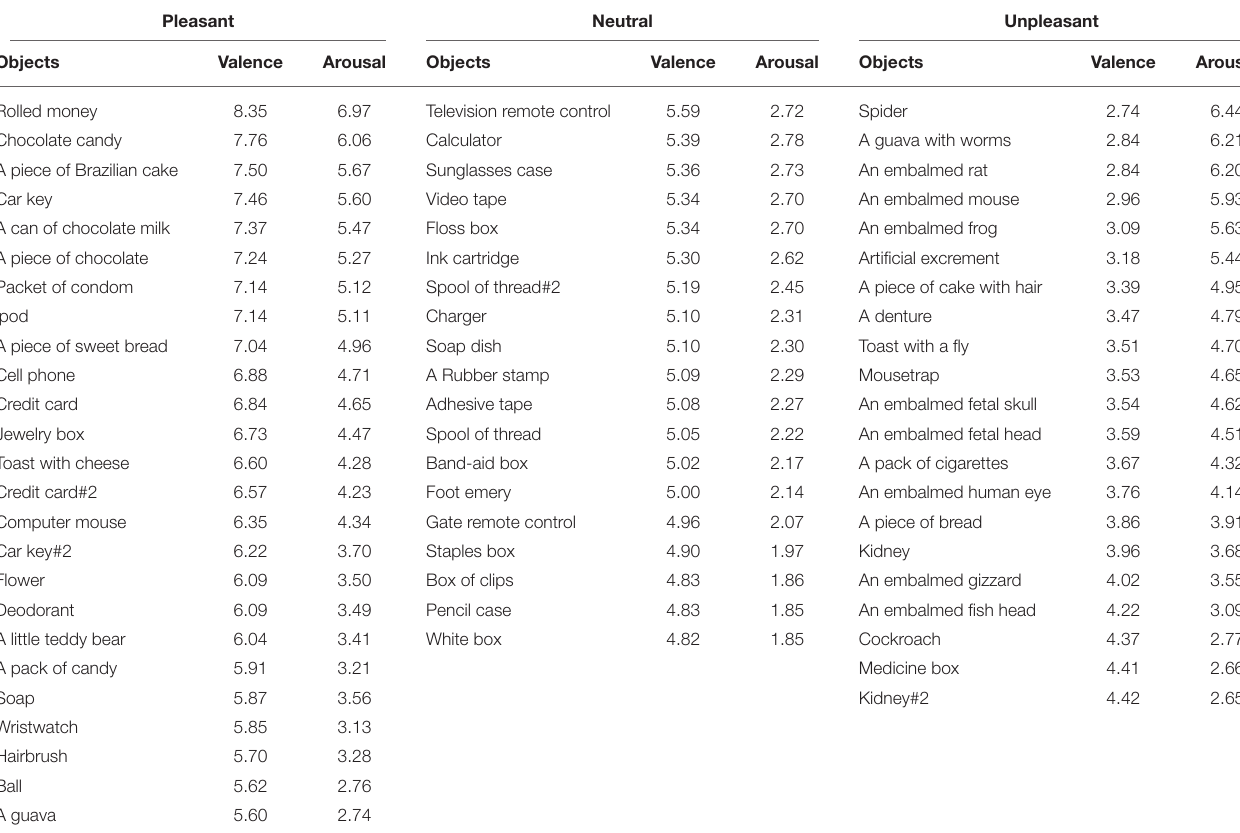
TABLE 1 | Valence and arousal ratings for each video-clip. Pleasant Neutral Unpleasant Arousal Objects Valence